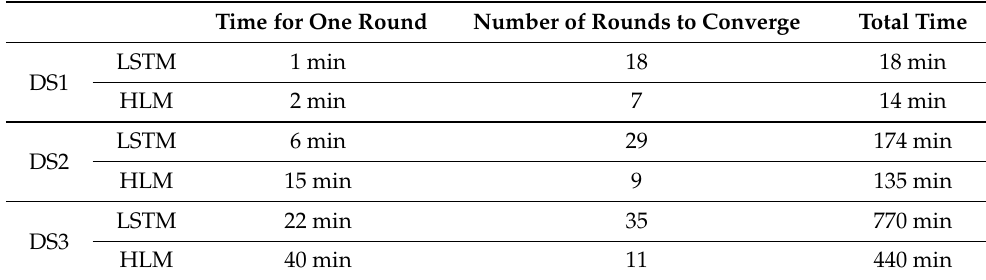
Table 3. Training time for different models. Time for One Round Number of Rounds to